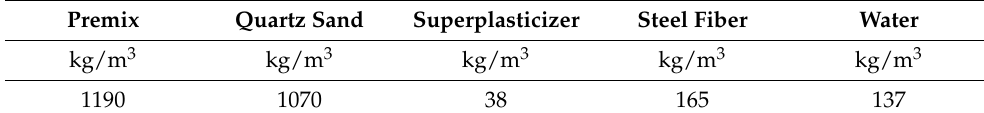
Table 1. Mixing proportion of UHPC.